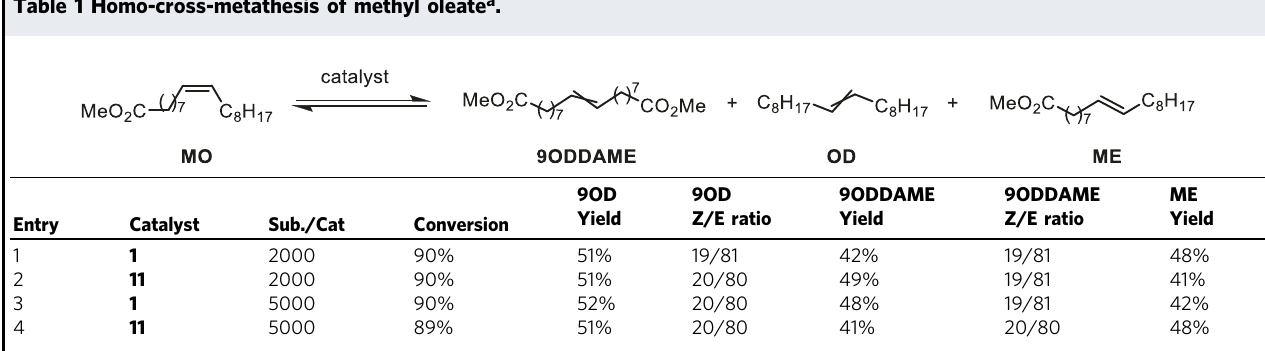
Table 1 Homo-cross-metathesis of methyl oleate a .